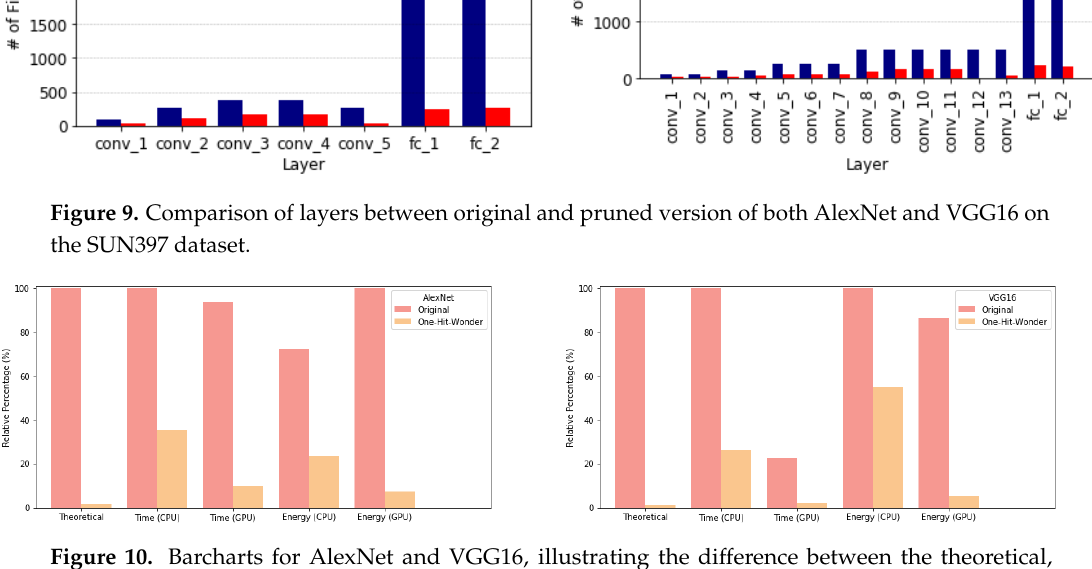
Figure 10. Barcharts for AlexNet and VGG16, illustrating the difference between the theoretical, CPU and GPU efficiency with respect to their computational speed and energy consumed on the SUN397